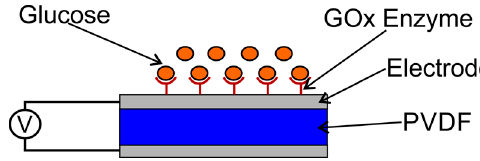
Figure 3. The scheme for glucose detection with a capacitive sensor [21].